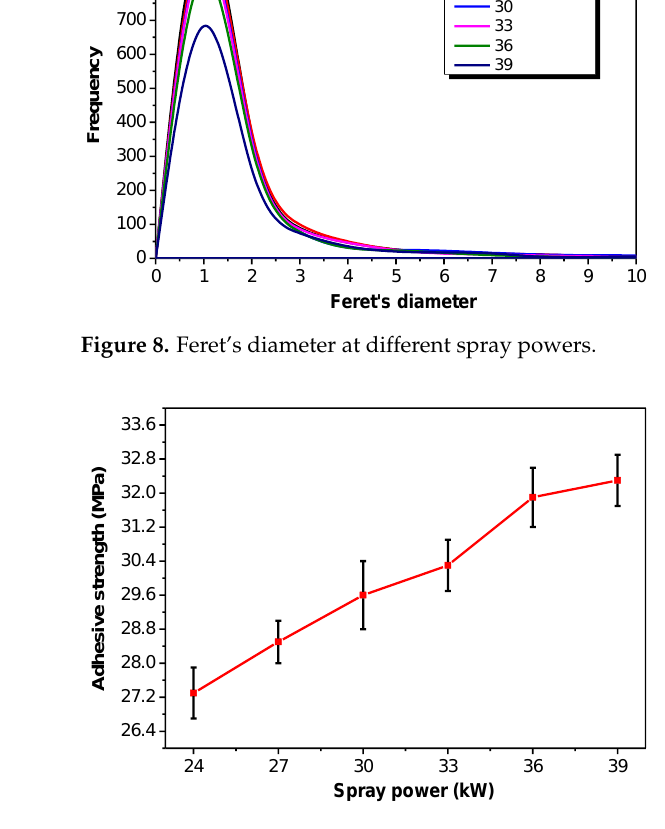
Figure 9. Adhesive strength at different spray powers.